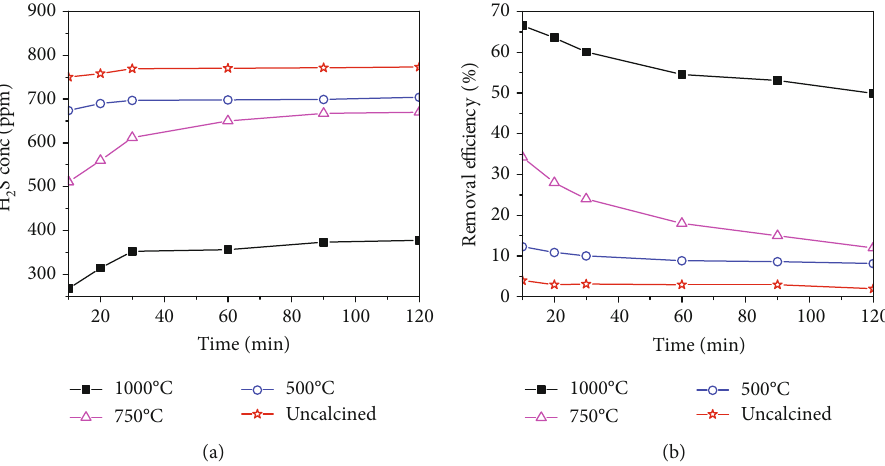
Figure 6: E ff ect of calcination temperature on the RR adsorption performance: H conditions: mass = 0 : 1g , FR = 0 : 06m 3 /h , particle size = 0 : 32 ‐ 250 μ m , and C